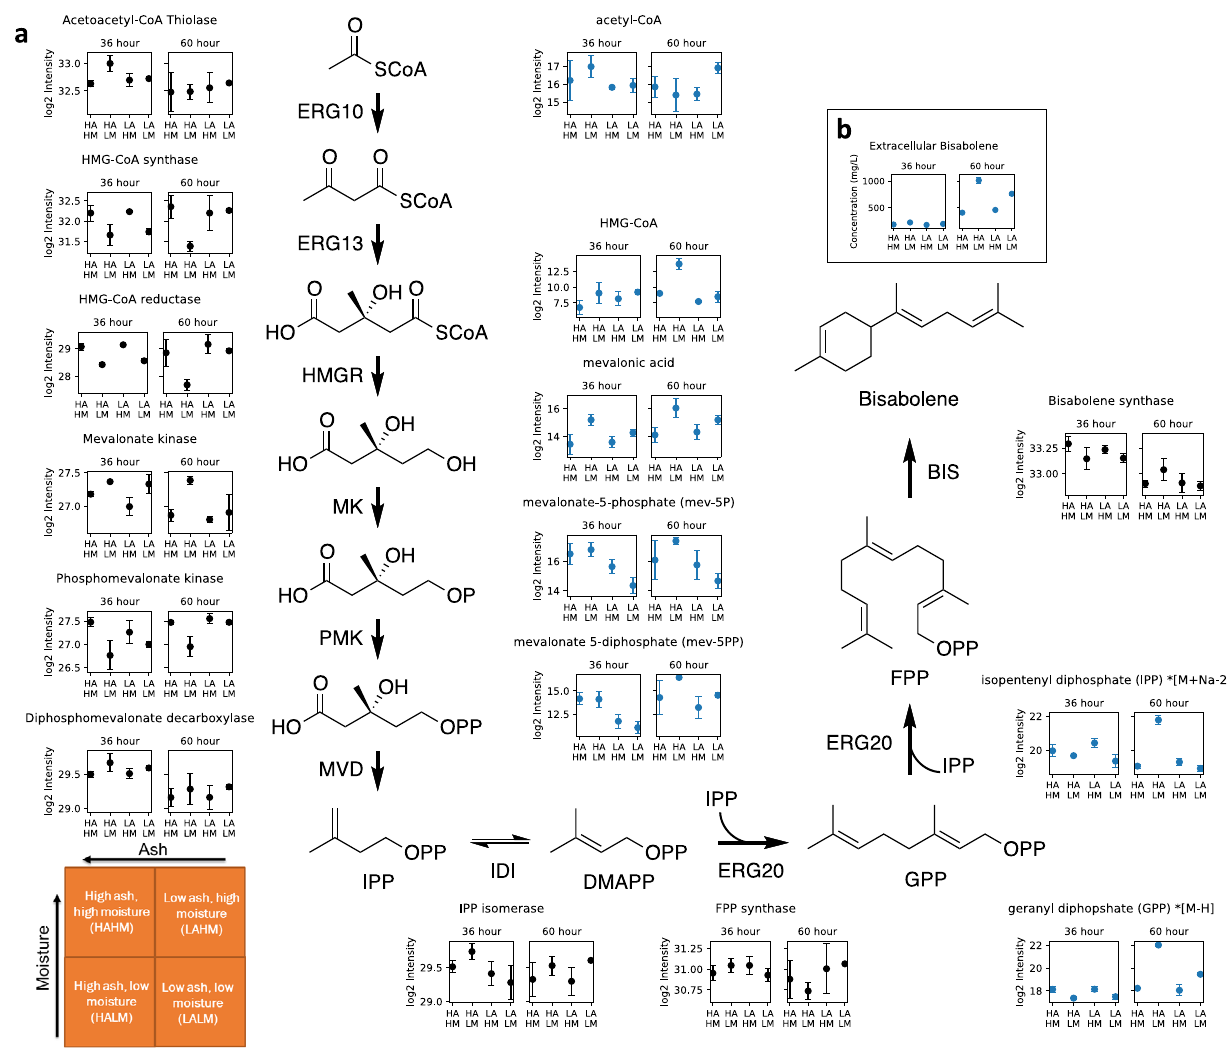
Fig. 7 | Metabolite and enzyme levels in the mevalonate pathway of R. tor- uloides strains. a Relative and label-free abundance levels are represented in blue formetabolomics( n =48,with24samplesand2collisionenergiespersample)and black for proteomics ( n =24 samples). Strains were grown in hydrolysates with